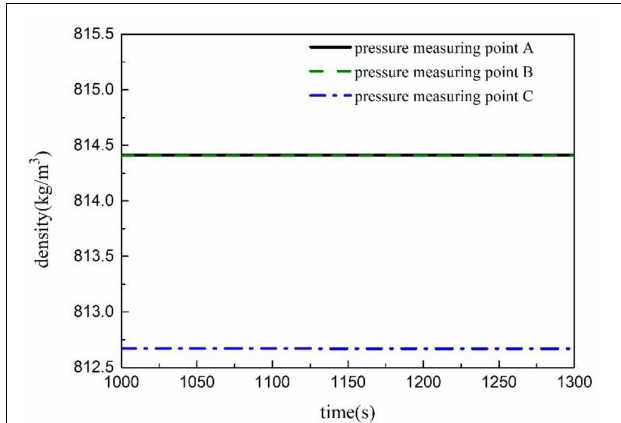
FIGURE 4 | The density of pressure tapping point under steady state condition.